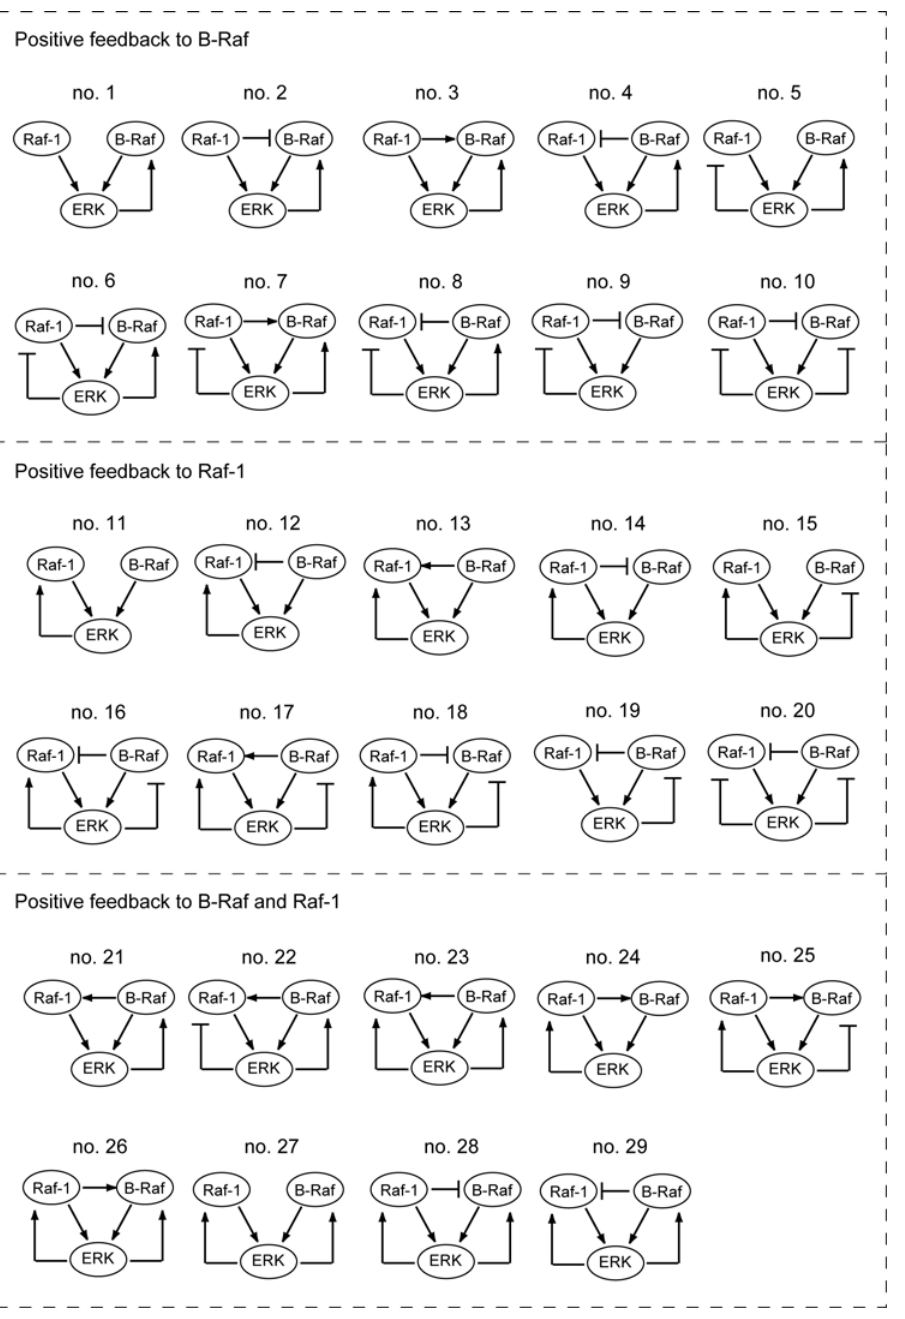
Figure 3. The 29 pathway structures that possess positive feedback by ERK to Raf. The 29 pathway structures that possess positive feedback by ERK to Raf isoforms can be classified into three types of regulation depending on which isoform is positively regulated: B-Raf (nos. 1–10), Raf-1 (nos. 11–20), or both B-Raf and Raf-1 (nos. 21–29). The symbol for MEK is omitted here for clarity.